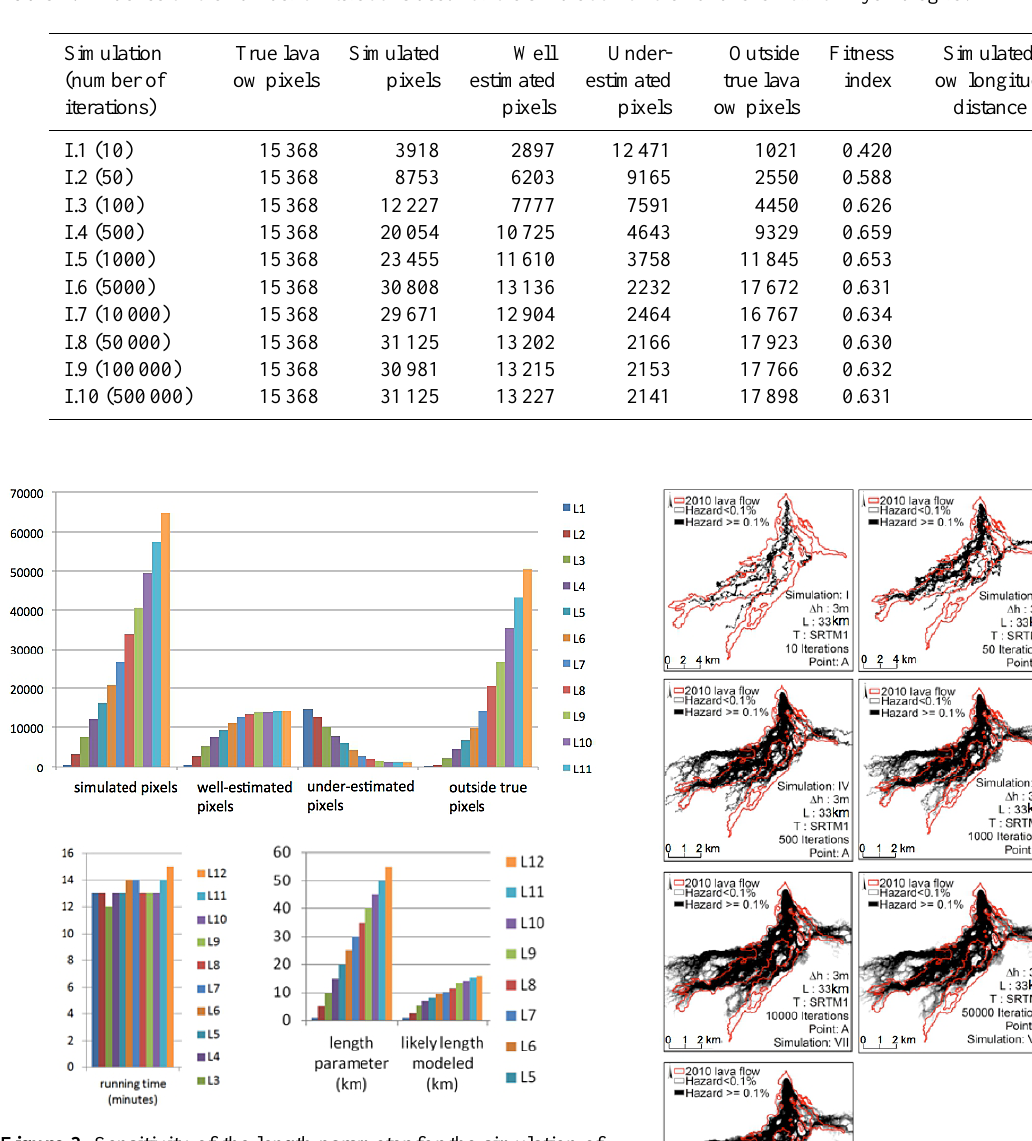
Table 2. Influence of the number of iterations used for the simulation of the 2010 lava flow of Nyamulagira.